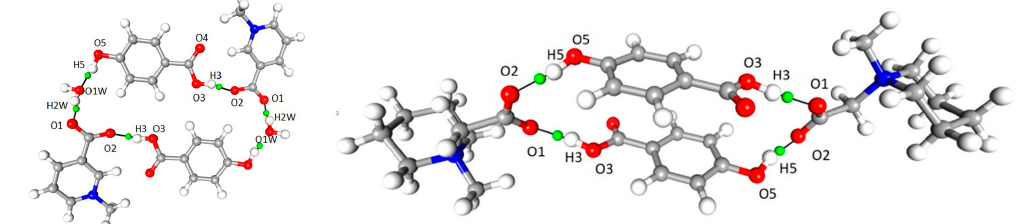
Figure 9. OH ··· O interaction, bond path and associated critical point in 1 ( left ) and 2 ( right